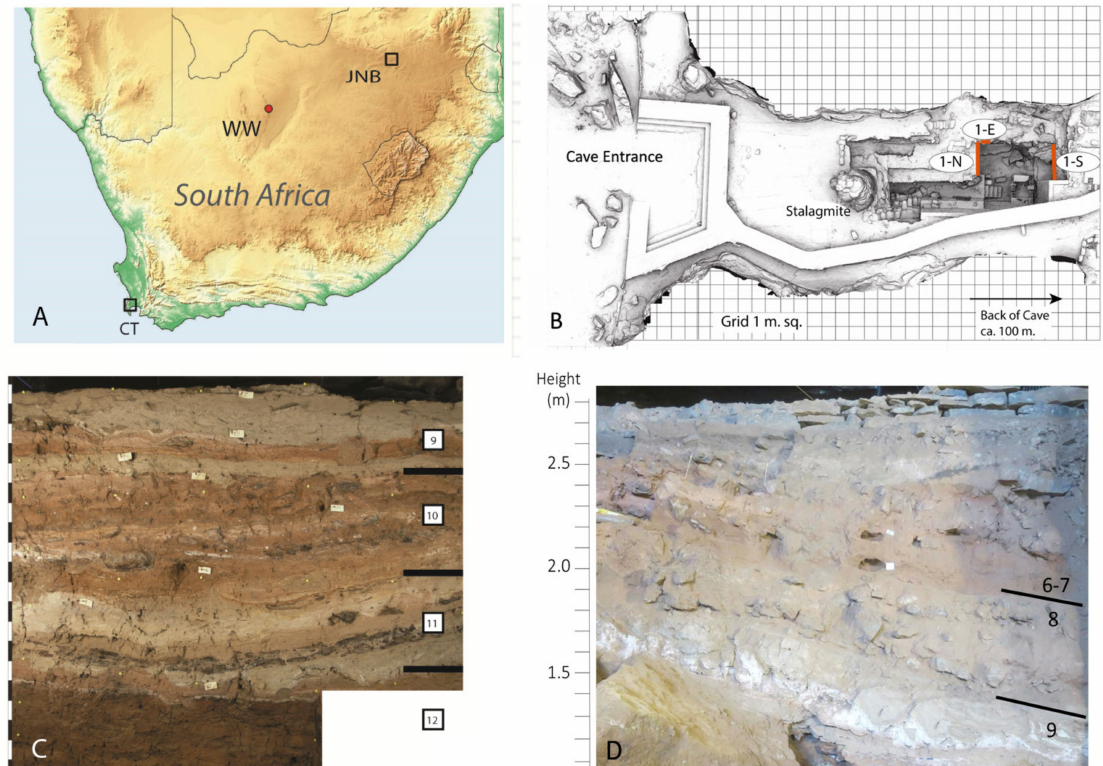
Figure 4. ( A ) Location of Wonderwerk Cave (WW) in South Africa (JNB = Johannesburg; CT = Cape Town). ( B ) Annotated laser scan of Excavation 1 in the cave where 1-N = North Profile, 1-S = South Profile, 1-E = East Profile (scan courtesy of the ZAMANI project, University of Cape Town). ( C ) Stratig- raphy of North Profile showing Strata 12 (bottom) to 9 (top) of the sequence. ( D ) Stratigraphy of South Profile showing location of Strata